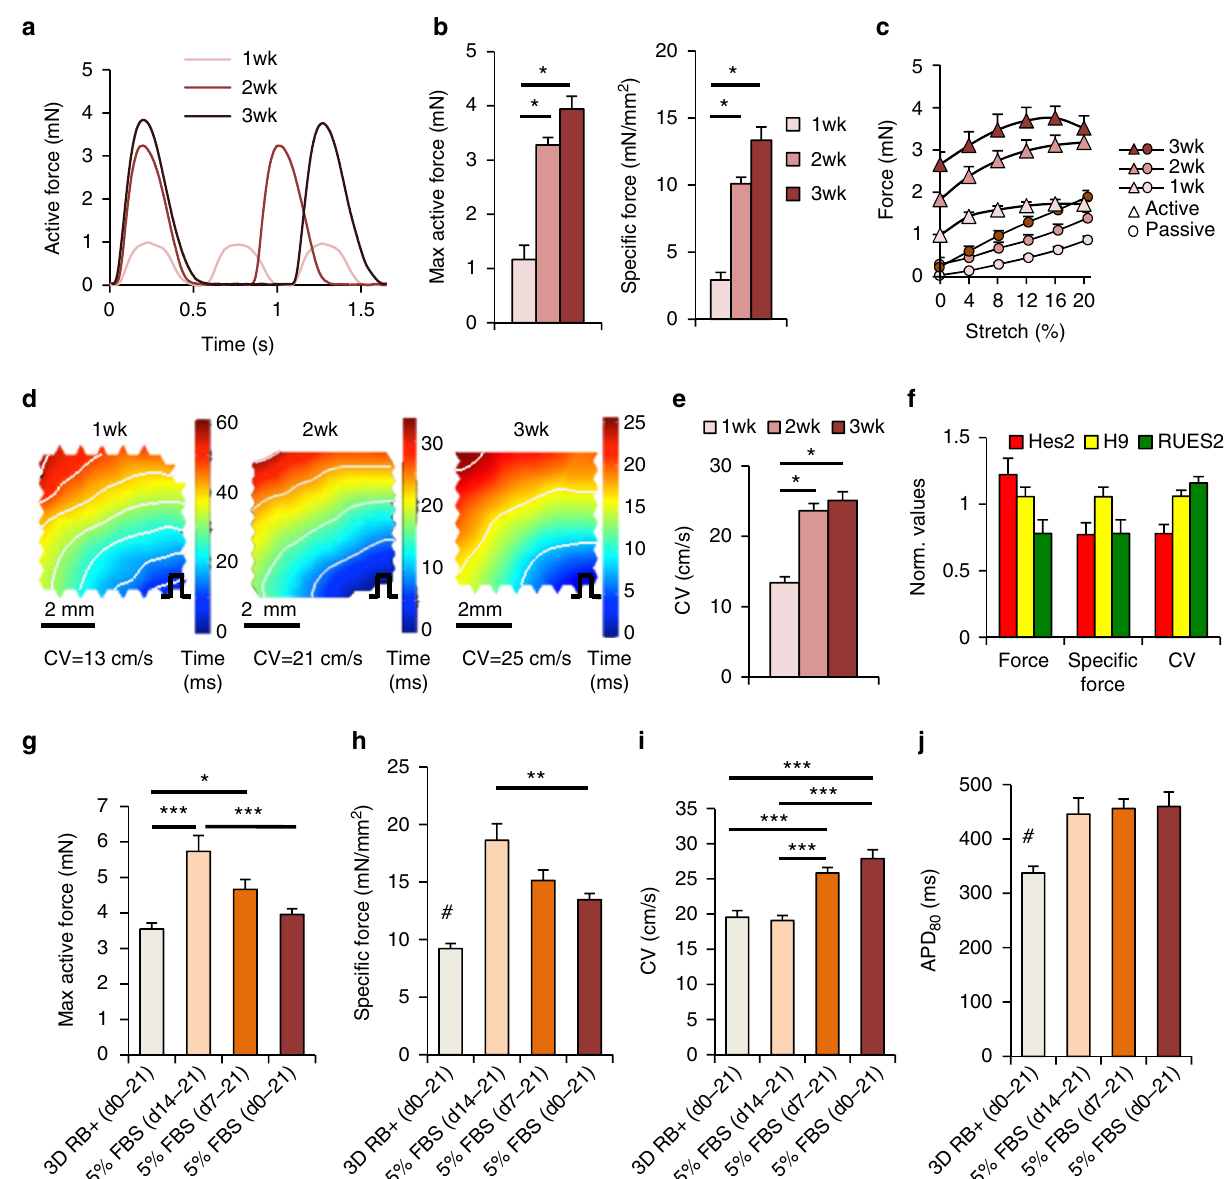
Fig. 2 Functional assessment and maturation of human cardiopatches. a Representative isometric contractile (active) force traces of spontaneously beating hiPSC-CM cardiopatches at 1, 2, and 3 weeks of culture. b Maximum active force (left) and speci fi c force (right) of 1, 2, and 3-week-old cardiopatches; n = 6 patches from two differentiations; * p < 0.0001, post hoc Tukey ’ s test. c Active and passive force – length relationships of isometrically tested (1 Hz stimulation) cardiopatches at 1, 2, and 3 weeks of culture; same patches as in b . d , e Representative isochrone activation maps ( d ) and average conduction velocities (CV, e ) during point stimulation from bottom right corner (pulse sign) of cardiopatches at 1, 2, and 3 weeks of culture; n = 7/7/9 patches (for 1/2/3 weeks) from two differentiations; * p < 0.0001, post hoc Tukey ’ s test. Scale bars d , 2 mm. f Average active force, speci fi c force, and CV in cardiopatches obtained from three additional hESC lines (Hes2, H9, and RUES2) normalized to those made of hiPSC-CMs; n = 18/37/22 patches (for Hes2/H9/RUES2) from fi ve to seven independent differentiations per line. g , h Maximum active force ( g ) and speci fi c force ( h ) of cardiopatches cultured for 3 weeks in 3D RB + medium or 1, 2, and 3 weeks in 5% FBS medium; n = 15/14/13/14 patches (for 3D RB+/1/2/3 weeks in 5% FBS) from fi ve differentiations; * p = 0.0026, ** p = 0.0005, *** p < 0.0001, # p < 0.001 vs. all other groups, post hoc Tukey ’ s test. i , j CV ( i ) and action potential duration at 80% repolarization (APD 80 , j ) in cardiopatches cultured for 3 weeks in 3D RB + medium or 1, 2, and 3 weeks in 5% FBS medium; n = 15/15/14/15 patches (for 3D RB+/1/2/3 weeks in 5% FBS) from fi ve differentiations; *** p < 0.0001, # p < 0.002 vs. all other groups, post hoc Tukey ’ s test. Data are presented